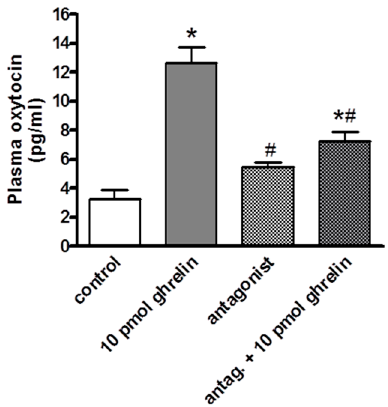
Figure 3. Effects of centrally (i.c.v.) administered ghrelin antagonist [D-Lys3]–GHRP-6 on the plasma oxytocin concentration (expressed as pg/mL). Results shown as means ± S.E.M., n = 10. Statistical significance: * p < 0.05 relative to the control group and # p < 0.05 relative to the 10 pmol ghrelin-treated group.